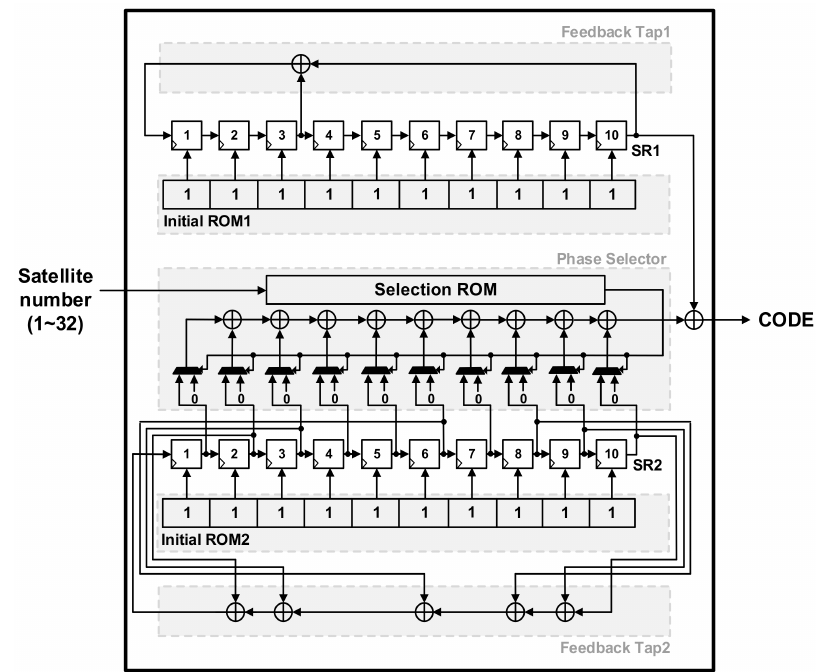
Figure 2. Conventional code generator architecture of GPS L1C/A signal